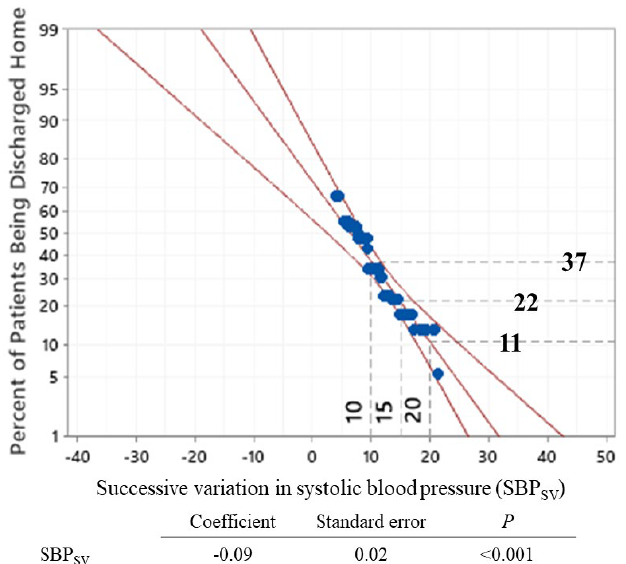
Figure 2. Probit and logit analysis demonstrating the probability of discharge home according to SBPSV (mm Hg).